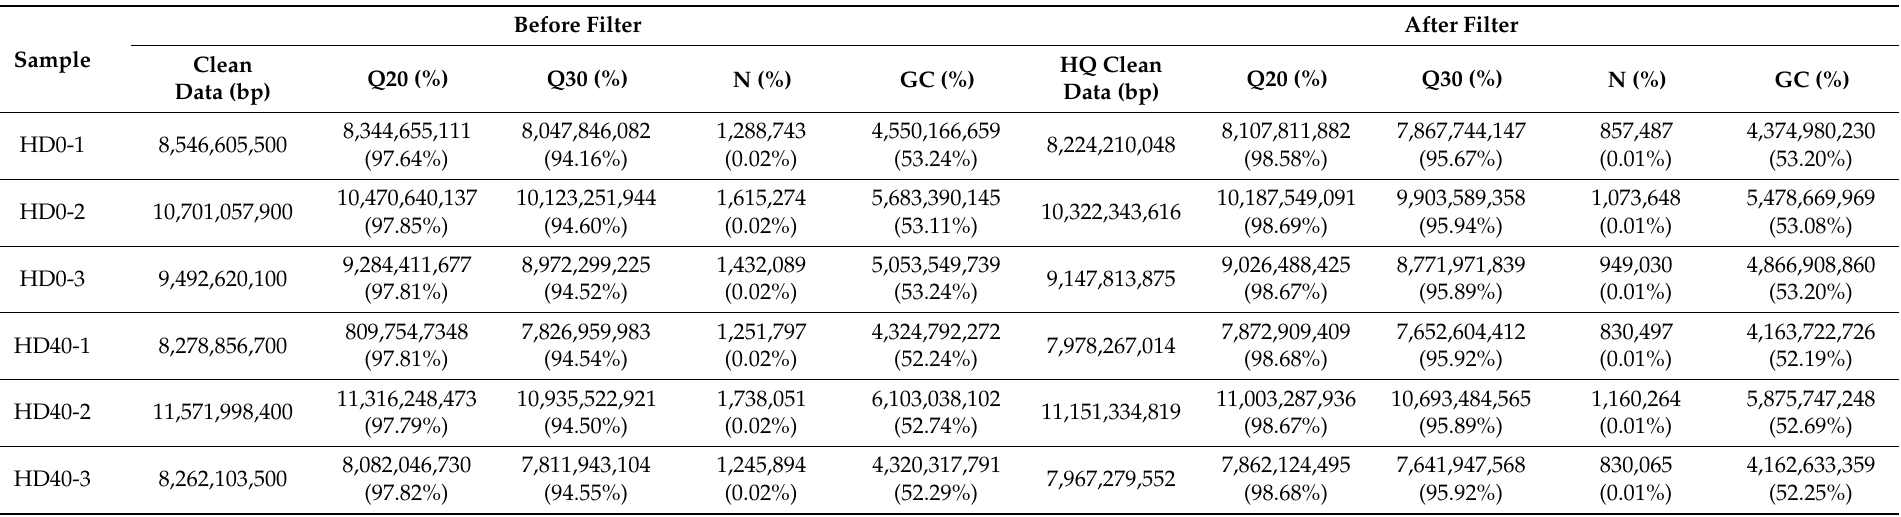
Table 4. Results of RNA-seq data quality